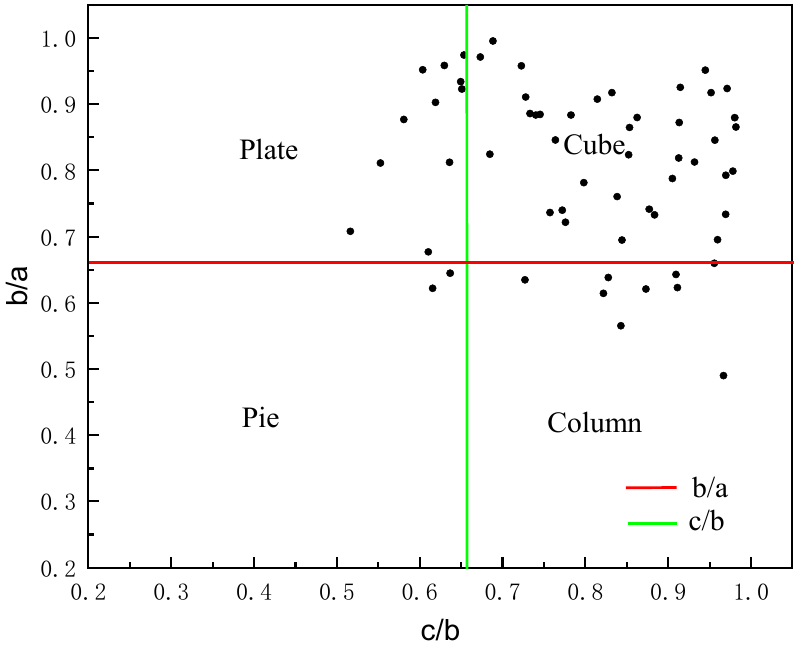
Figure 14. Coarse aggregate shape distribution.